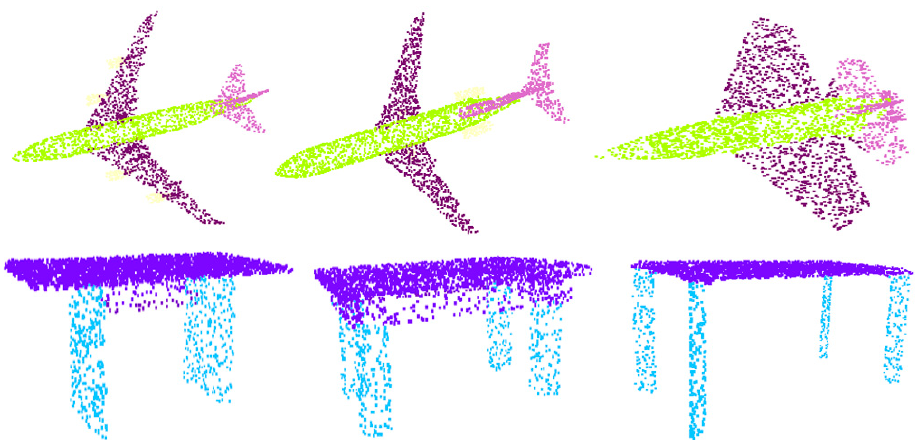
Figure 7. The visualized results of part segmentation.